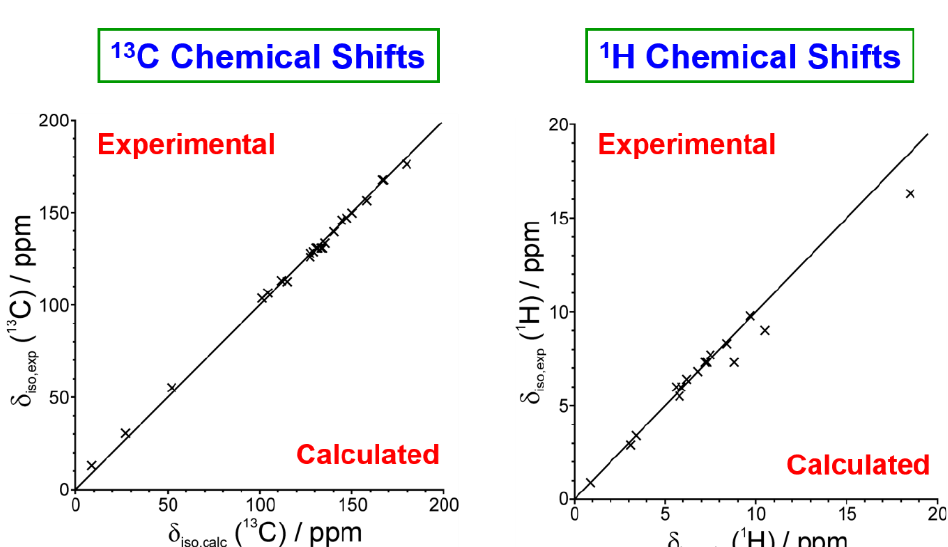
Figure 8. Comparison of experimental and DFT-GIPAW calculated values of isotropic 13 C NMR and 1 H NMR chemical shifts for the indomethacin-nicotinamide co-crystal.